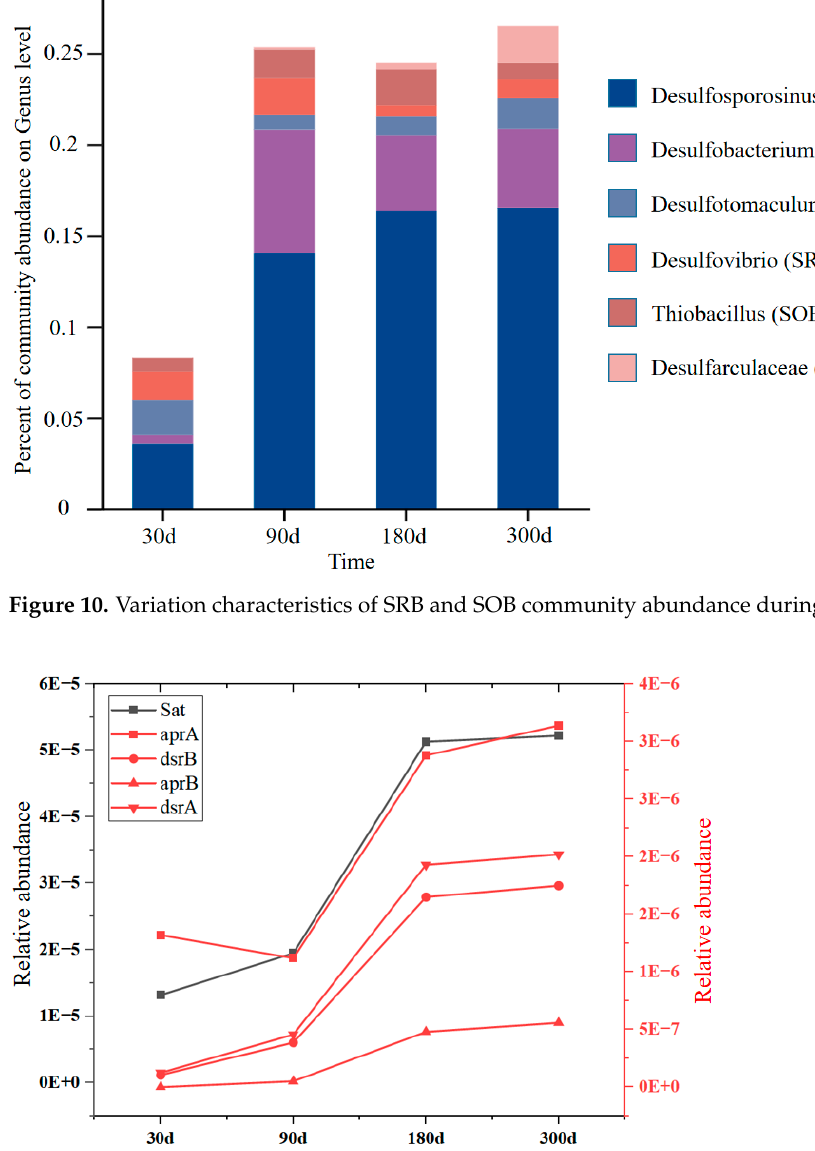
( b ) Figure 9. Color change of goaf water. ( a ) was taken on the 30th day of the experiment, and ( b ) was taken on the 300th day. 4.3.2. Action of Biochemistry A large number of studies have shown that the changes in goaf water hydrogeochem-